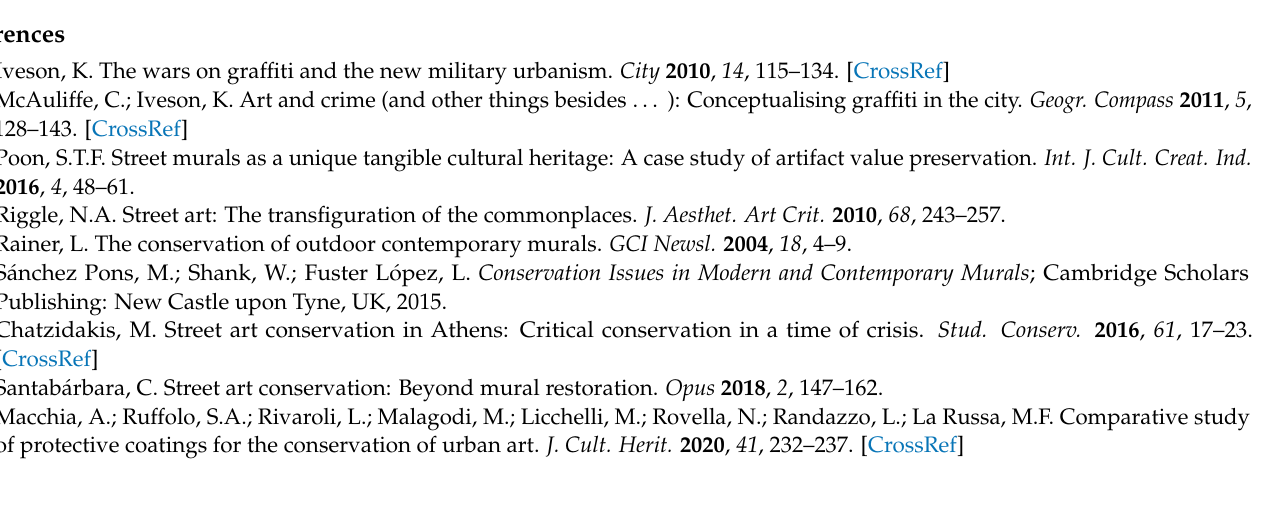
94, Table S2: Solubility tests on vandalized specimens with IVAS SP, Table S3: Solubility tests on vandalized specimens with Loop, Table S4: Solubility tests on vandalized specimens with Montana Water